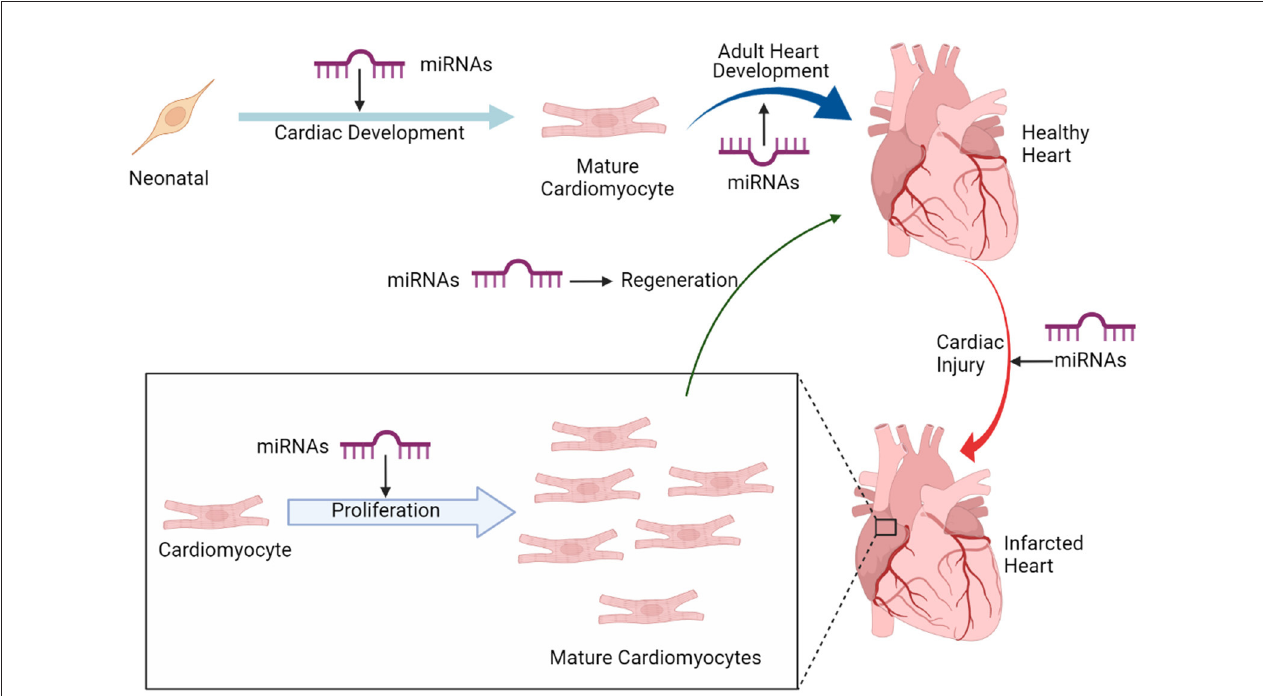
FIGURE 1 | miRNAs in cardiac development and